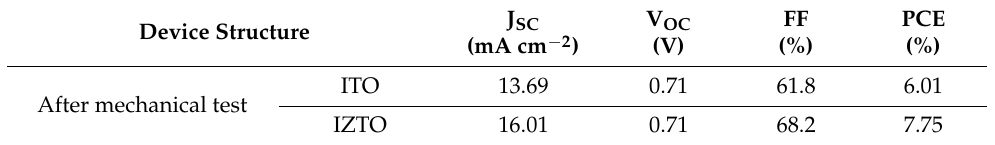
Table 2. Device characteristics of various device structures after mechanical